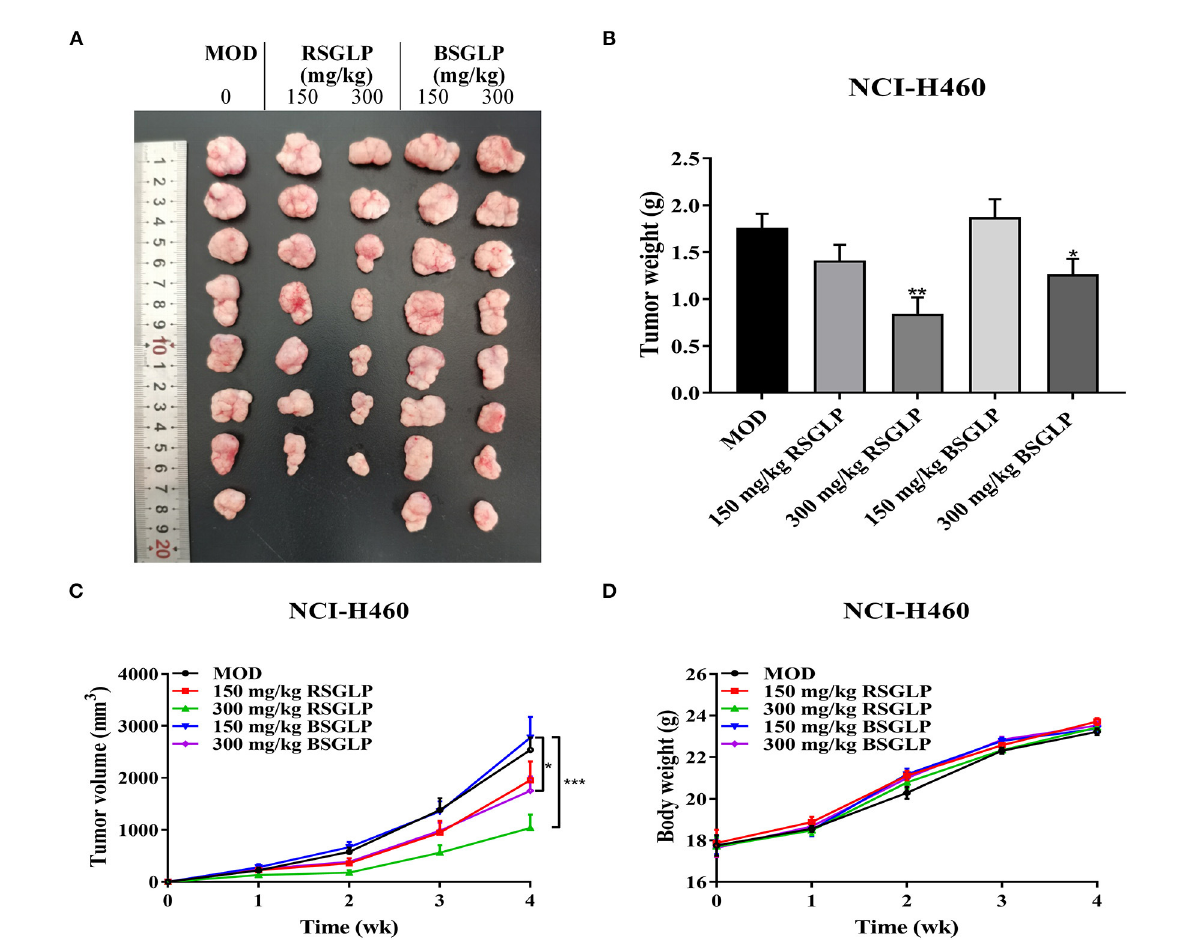
FIGURE4 Comparison of the antitumor activity of RSGLP and BSGLP in NCI-H460 xenograft nude mice. (A) Image of the tumor samples from each group. (B) Final tumor weight of each group. (C) Growth curve of tumor volume of each group. (D) Body weight of each group. Nude mice were treated with saline (Con and MOD), RSGLP and BSGLP (150 and 300 mg/kg) for 4 wk. MOD: model. All values are presented as the mean ± SE ( n = 7–8). * p < 0.05, ** p < 0.01, compared with MOD